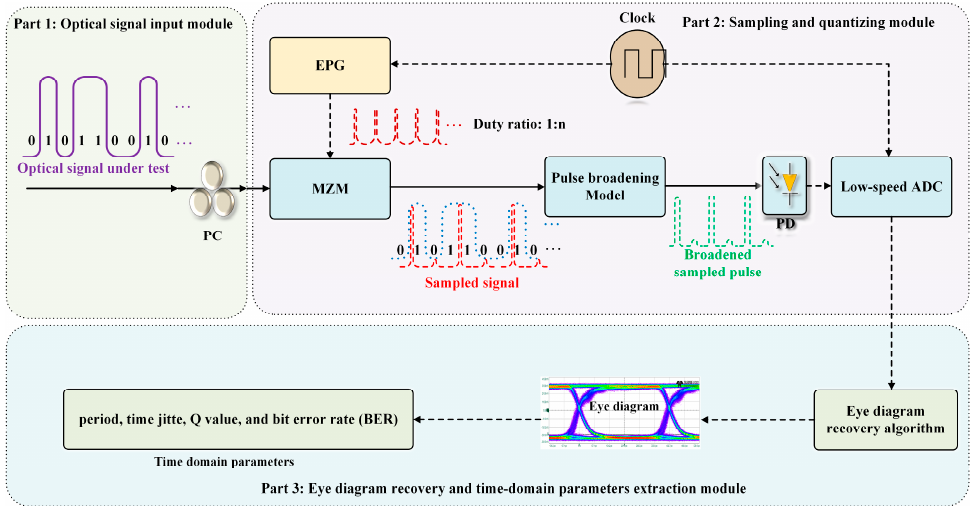
Figure 1. Schematic diagram of the proposed eye diagram monitoring method for an optical signal. PC: polarization controller; EPG: electrical pulse generator; MZM: Mach-Zehnder modulator; PD: photodetector; ADC: analog-to-digital converter; BER: bit error